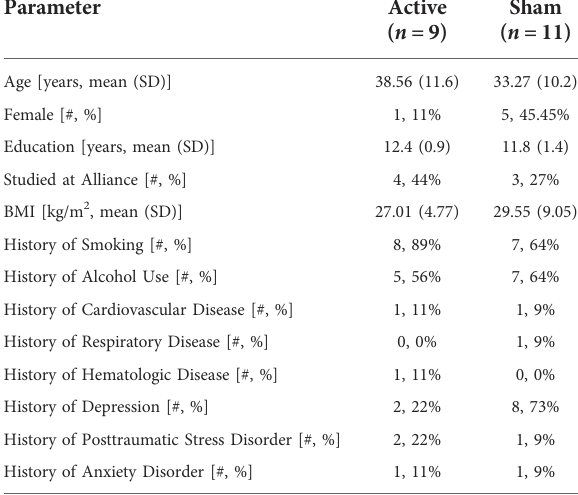
TABLE 1 Active vs. sham characteristics comparison.